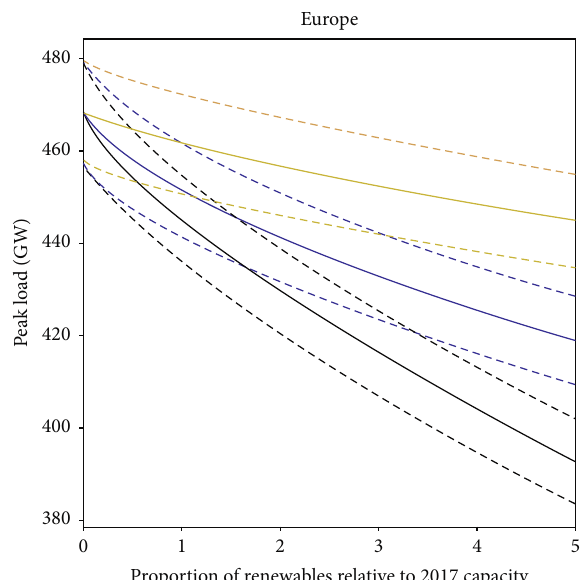
Figure 2: Mean European total peak load for various proportions of installed renewable generation, for 1979–2018. Solid lines give the 1979–2018 mean peak load, whereas dotted lines show 2 standard deviations from the annual-mean peak load. Line colours show demand-net-solar (yellow), demand-net-wind (blue), and demand-net-renewables